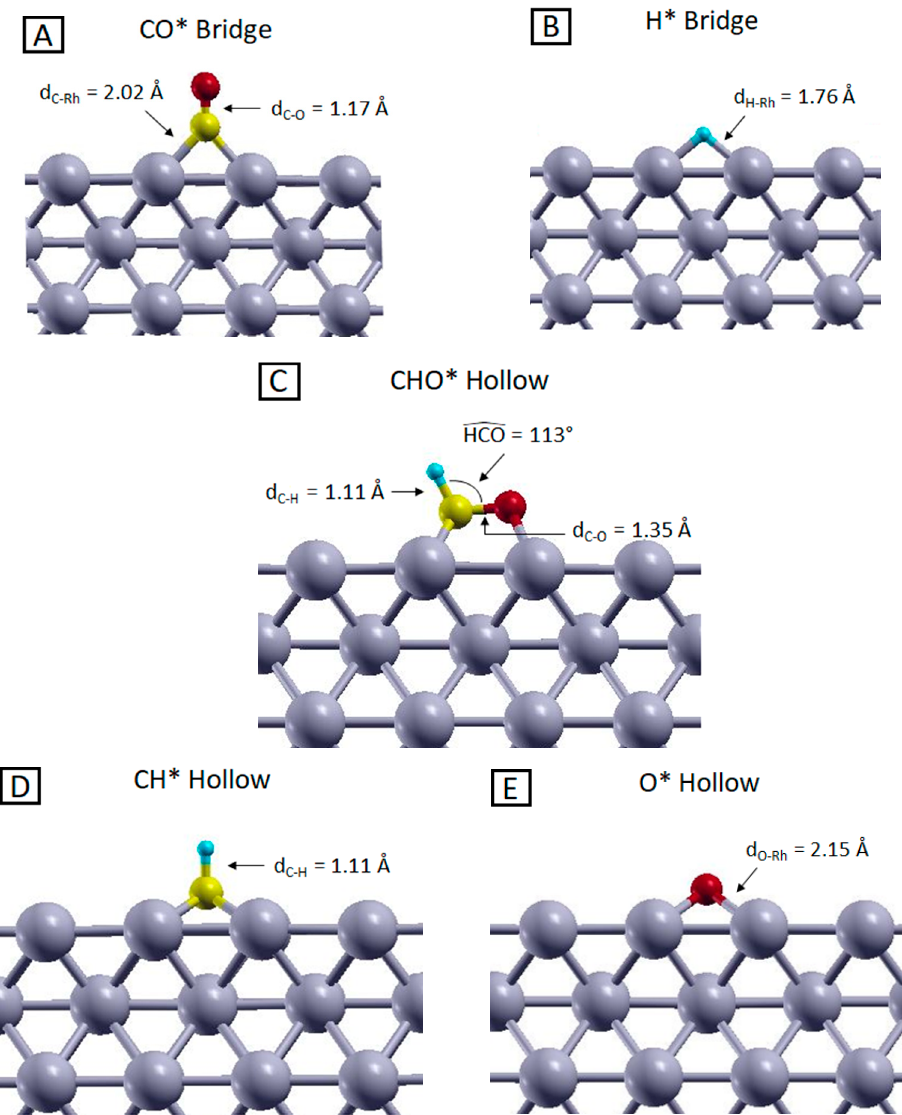
Figure 2. Side views of the most stable configurations of ( A ) CO, ( B ) H, ( C ) CHO, ( D ) CH and ( E ) O adsorbed on the Rh (100) surface, optimized at the PBE level. Yellow, red, light blue and grey represent C, O, H and Rh atoms, respectively.